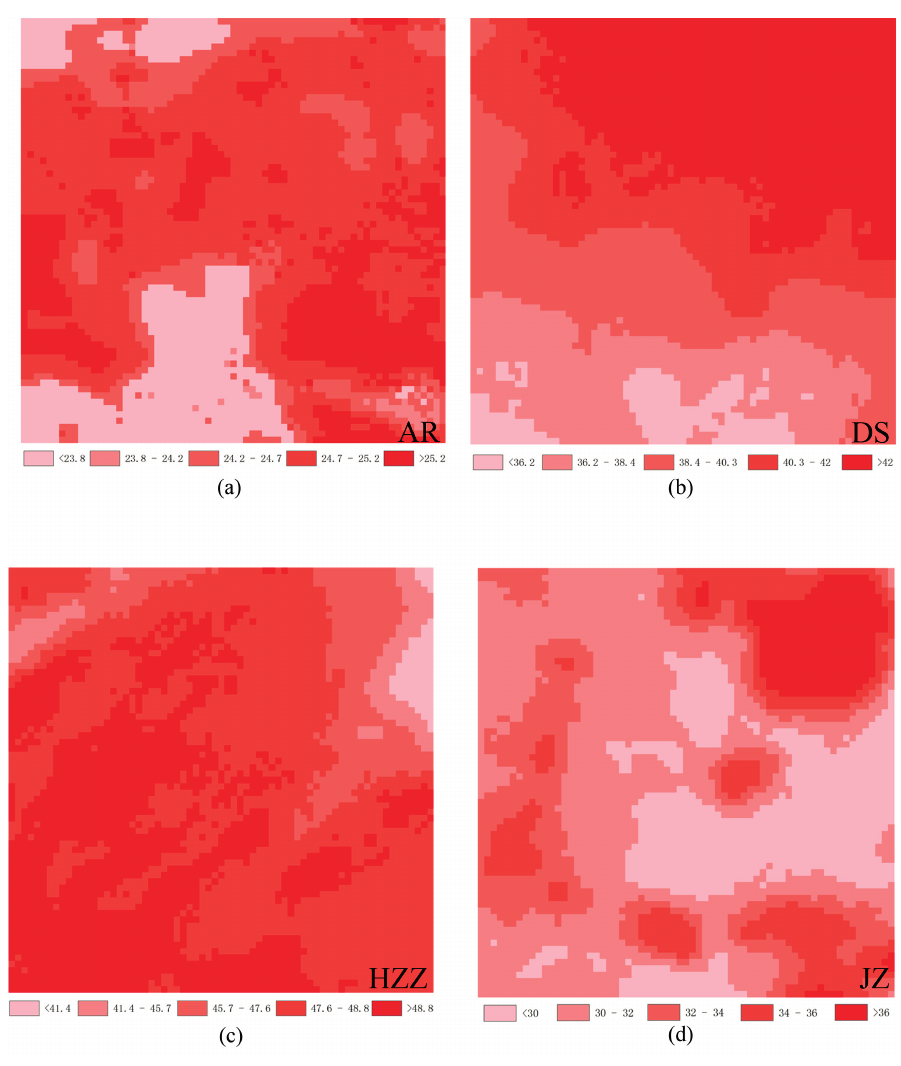
Figure 4. TM land surface temperature image of a 2 × 2-km region centered on each site. ( a ) AR station; ( b ) DS station; ( c ) HZZ station; ( d ) JZ station; ( e ) MQ station; ( f ) MY station; ( g ) NM station; ( h ) SPT station; ( i ) TYF station; ( j ) YK station; ( k ) TYG station; ( l )YZ